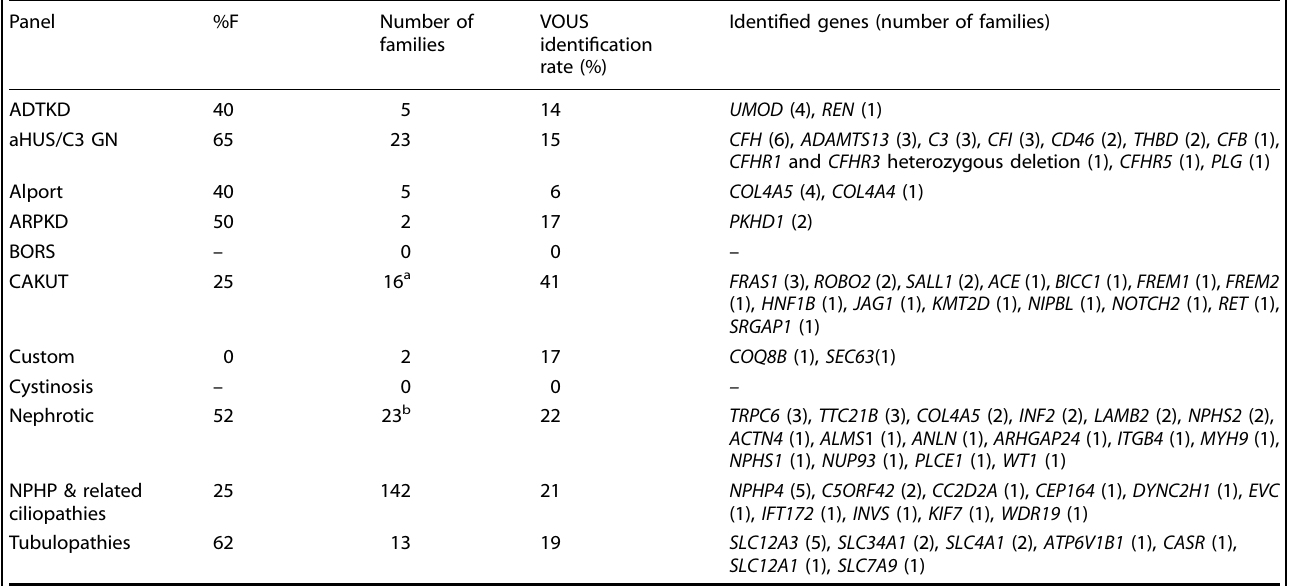
Table 3. Identi fi ed VOUS strati fi ed by panel.